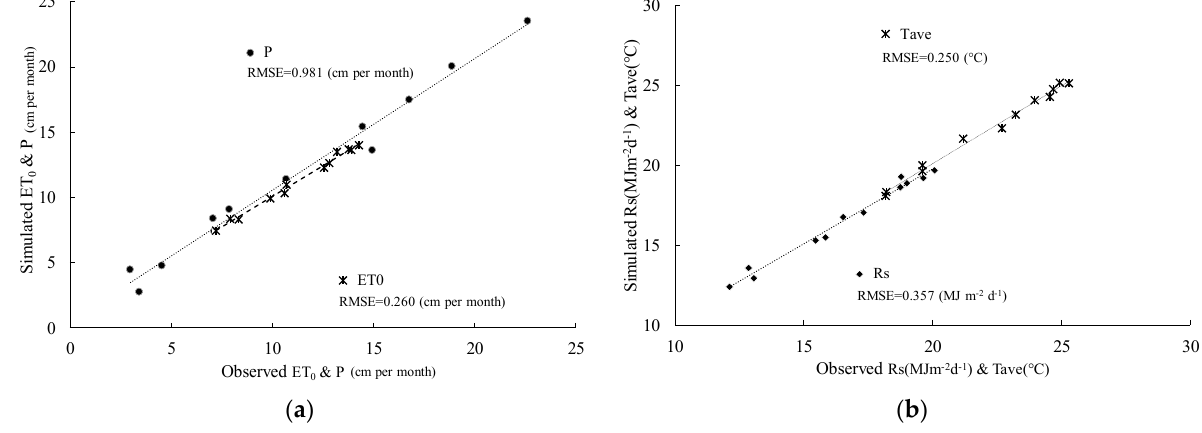
Figure 3. Observed meteorological data versus simulated ones by LARS-WG: ( a ) Rainfall (P) and evapotranspiration (ET 0 ); ( b ): radiation (R a ) and average temperature (T ave ).